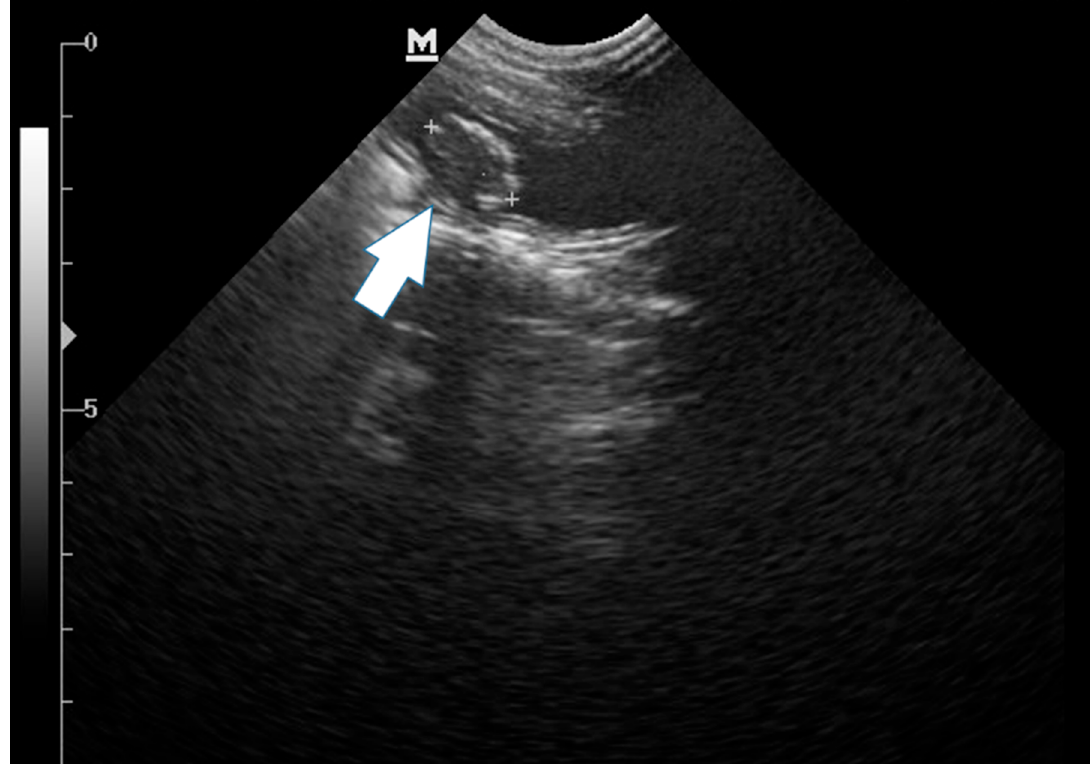
Figure 1. Longitudinal ultrasonographic image of the urinary bladder obtained with a curvilinear transducer of a primary bladder leiomyosarcoma. An ovoid adherent mass (white arrow) is apparent in the bladder lumen.